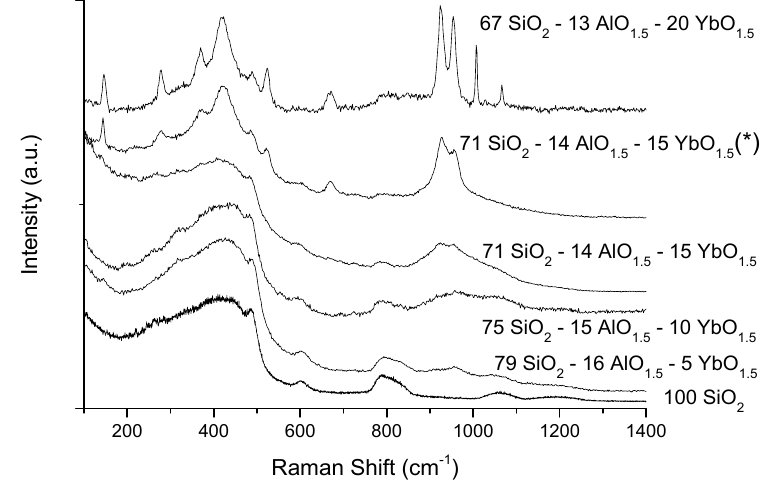
Figure 3. Raman spectra of Yb-doped aluminosilicate bulk glasses. The samples were heat treated at 1050 °C, except for the sample labelled (*) which was heat-treated at 1100 °C.